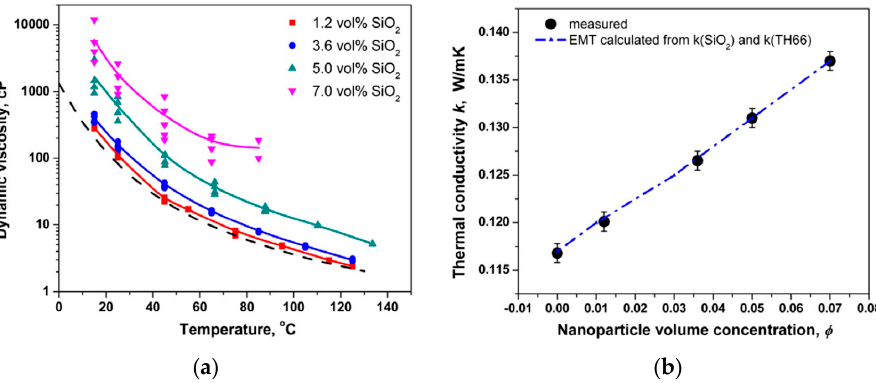
Figure 5. ( a ) Temperature dependence of the dynamic viscosity of TH66 ‐ based nanofluids at various SiO 2 concentrations with ~0.12 M of BAC (Benzalkonium chloride) surfactant. Multiple symbols of the same type and color represent the viscosity at shear stresses from 10 to 40 D/cm 2 with higher viscosity at lower shear stress; ( b ) Thermal conductivity of SiO 2 suspensions in TH66 with various particle concentrations and ~0.12 M BAC surfactant. Dashed ‐ dotted line represents the thermal conductivity values calculated from EMT (effective medium theory) equation [56].